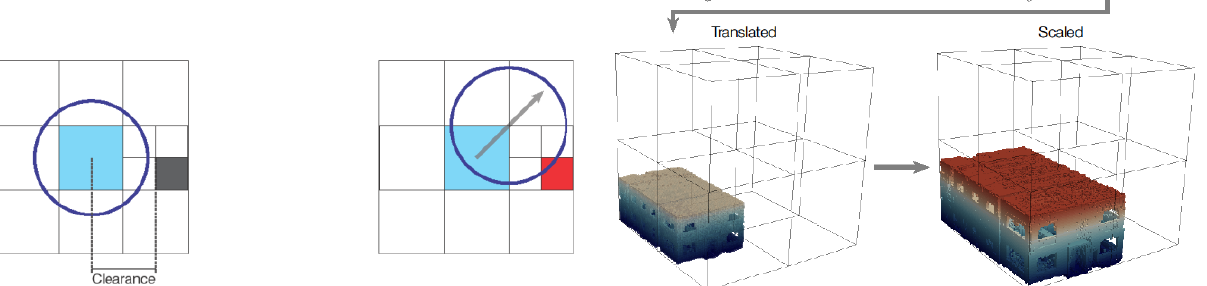
Figure 9: Collision avoidance: Centre point is collision free (left), but movement collides (right)